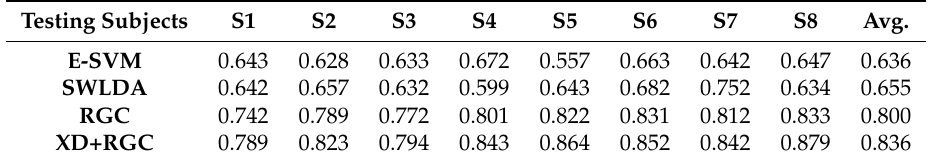
Table 5. All-to-One transfer learning AUC score results of Dataset I. The first and second rows represent the results obtained using the classic E-SVM and SWLDA methods. The third row (XD + RGC) represents the results obtained by our proposed XDAWN + RGC method. The last column represents the average AUC value of all subjects.